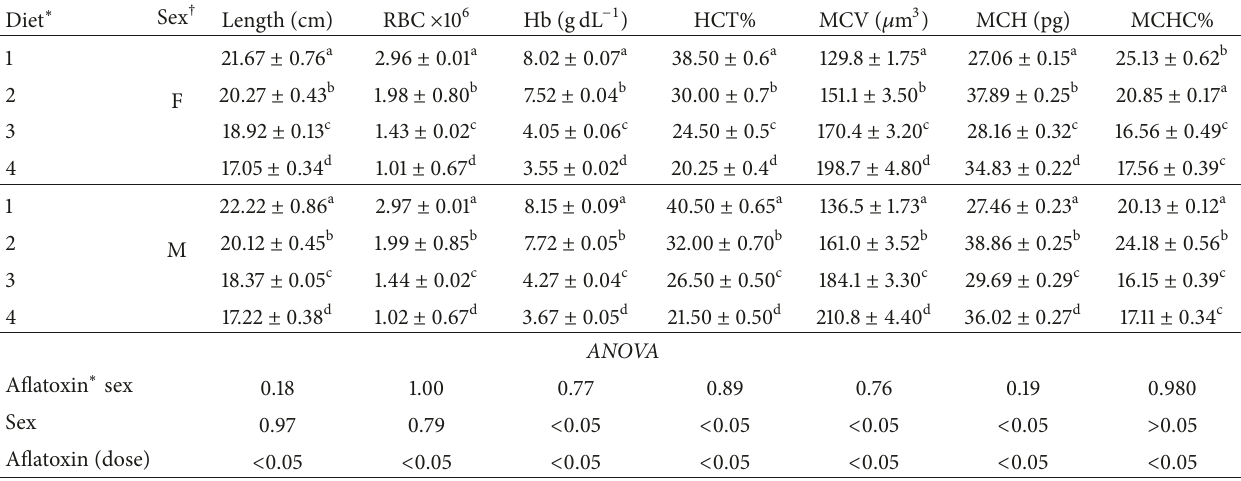
Table 3: Mean ± SE of hematological parameters of male and female O. niloticus exposed to different levels of AFB 1 for 24 weeks.